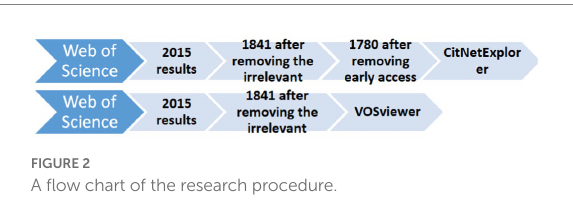
FIGURE 2 A flow chart of the research